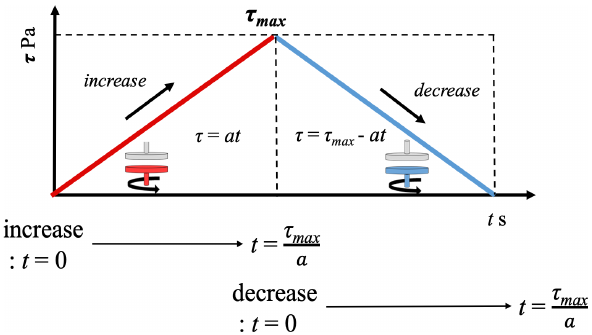
Figure 1: Outline of the hysteresis loop test. During the increasing segment, the shear stress increases from zero to the maximum applied stress at a constant rate. During the decreasing segment, the shear stress decreases from the maximum applied stress to zero at the same constant rate